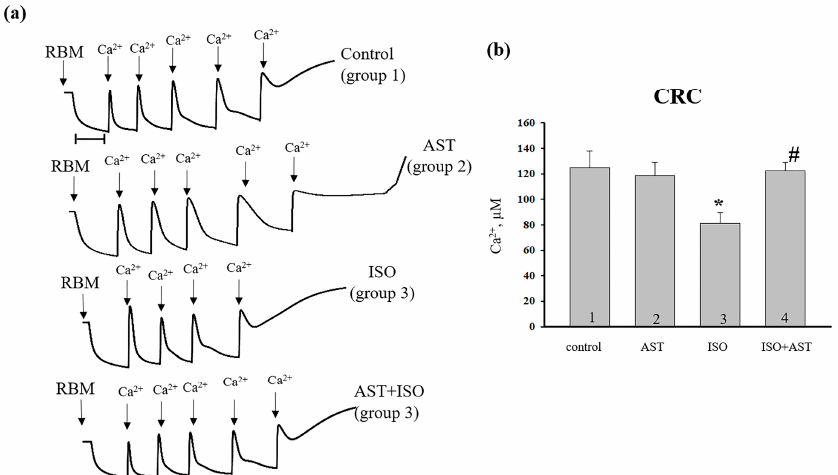
Figure 3. Effect of AST and ISO on the CRC in RBM upon mPTP opening. ( a ) Alterations in Ca 2+ flows in RBM isolated from each group of rats; ( b ) quantitative analysis of the Ca 2+ retention capacity in RBM isolated from the rats of every group. The data are presented as the means ± SDs of six independent experiments. * p < 0.05 indicates a significant difference in CRC relative to the control (group 1). # p < 0.05 shows a significant difference in CRC compared with ISO alone (group 3).